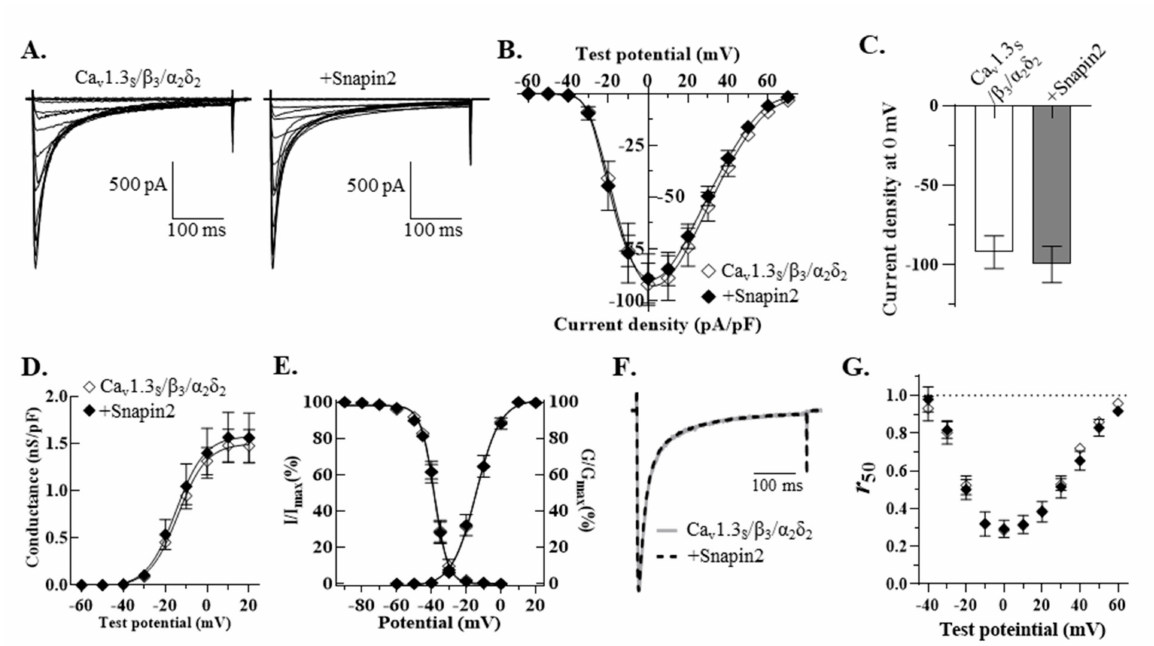
Figure 4. No regulatory effect of Snapin2 on Ca v 1.3 S . ( A ) Representative current traces through Ca v 1.3 S / β 3 / α 2 δ 2 co- expressed without (left) or with Snapin2 (right). Ca v 1.3 S current traces were evoked in response to the I-V protocol (described in Figure 2) in 10 mM Ca 2+ solution. ( B , C ) I-V relationships of Ca v 1.3 S channels without ( ) or with Snapin2 (cid:51) ). Average current density values (pA/pF) were plotted against test potentials (n = 8). ( C ) The average peak current density values at 0 mV test potential are represented as bar graphs ( − 92.1 ± 10.2 vs. − 89.3 ± 11.9 pA/pF; n = 8). ( D ) No effect of Snapin2 on the chord conductance of Ca v 1.3 S channels. The chord conductance values were normalized to the cell capacitance and plotted against test potentials (1.5 ± 0.2 vs. 1.6 ± 0.3 nS/pF; n = 8). ( E ) Activation and channel availability curves of Ca v 1.3 S channels co-expressed without or with Snapin2. Activation and channel availability curves of Ca v 1.3 S channels were obtained by the same methods in Figure 2 legend (n = 8). ( F ) Snapin2 effect on the CDI of Ca v 1.3 S channels. Ca v 1.3 S Ca 2+ current traces elicited at 0 mV test potential were superimposed, exhibiting no difference in CDI. ( G ) No alteration in the r 50 value of Ca v 1.3 S . The r 50 values of Ca v 1.3 S channels ( ± Snapin2) were plotted against test potentials (n = 5). No differences in the r 350 values were detected (data not